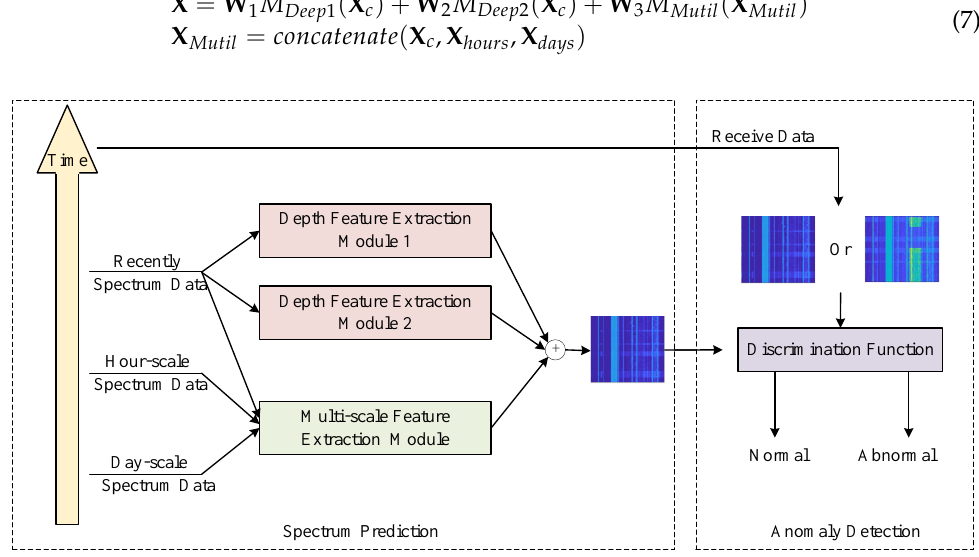
Figure 3. Whole framework of spectrum anomaly